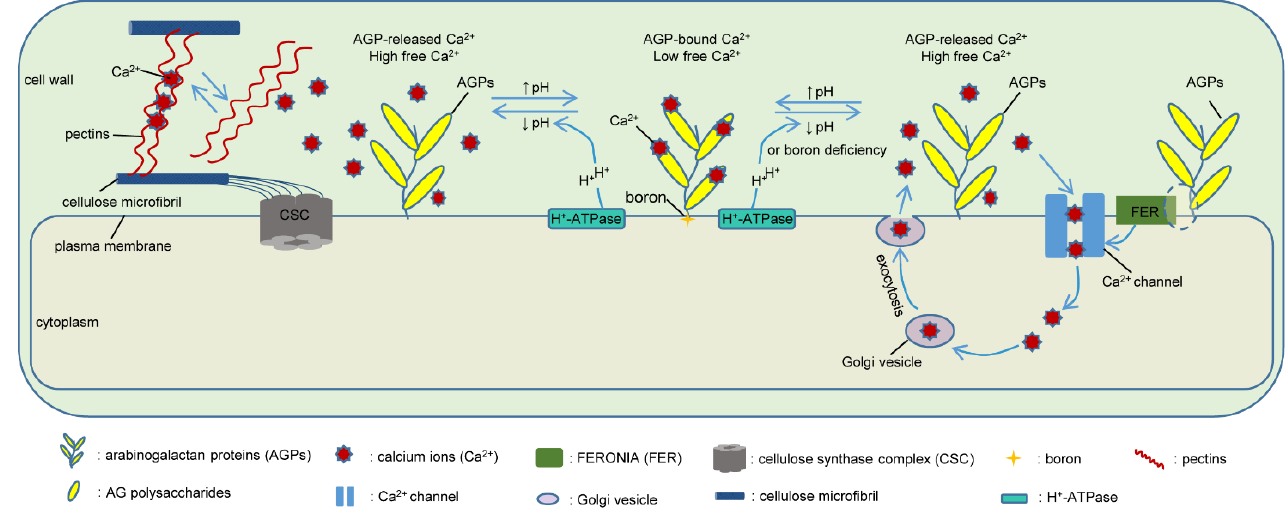
Figure 5. A hypothetical model of AGPs acting as putative Ca 2+ capacitors to regulate cellulose deposition in the cell wall possibly through pectin–Ca 2+ cross-links. The AGP–Ca 2+ oscillator refers to Lamport et al. [43].